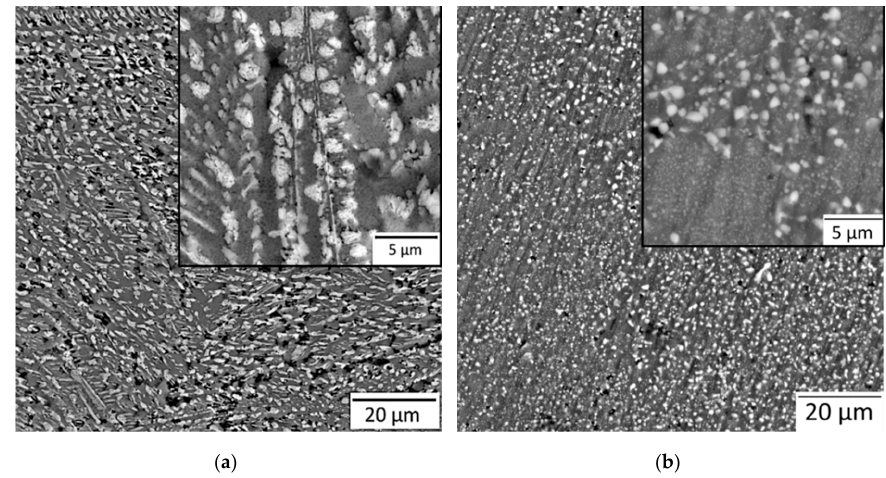
Figure 9. Microstructure of the Al8Zn7Ni3Mg alloy after 470 ◦ C heat treatment: ( a ) 1 mm cast sample; ( b ) MS